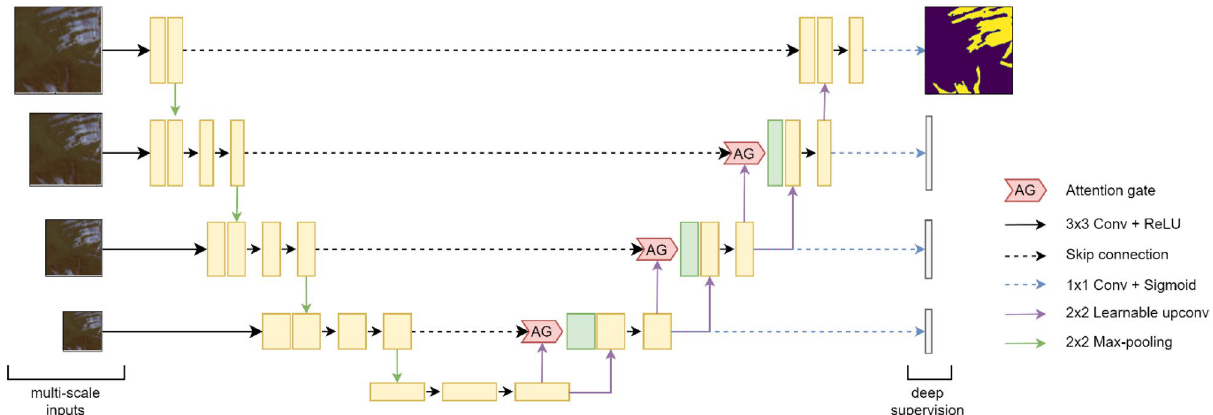
Figure 13. Model architecture of the Attention Deep Supervision Multi-Scale U-Net. (We generated TensorFlow implementation of the model which is shared with this paper in the Supplementary